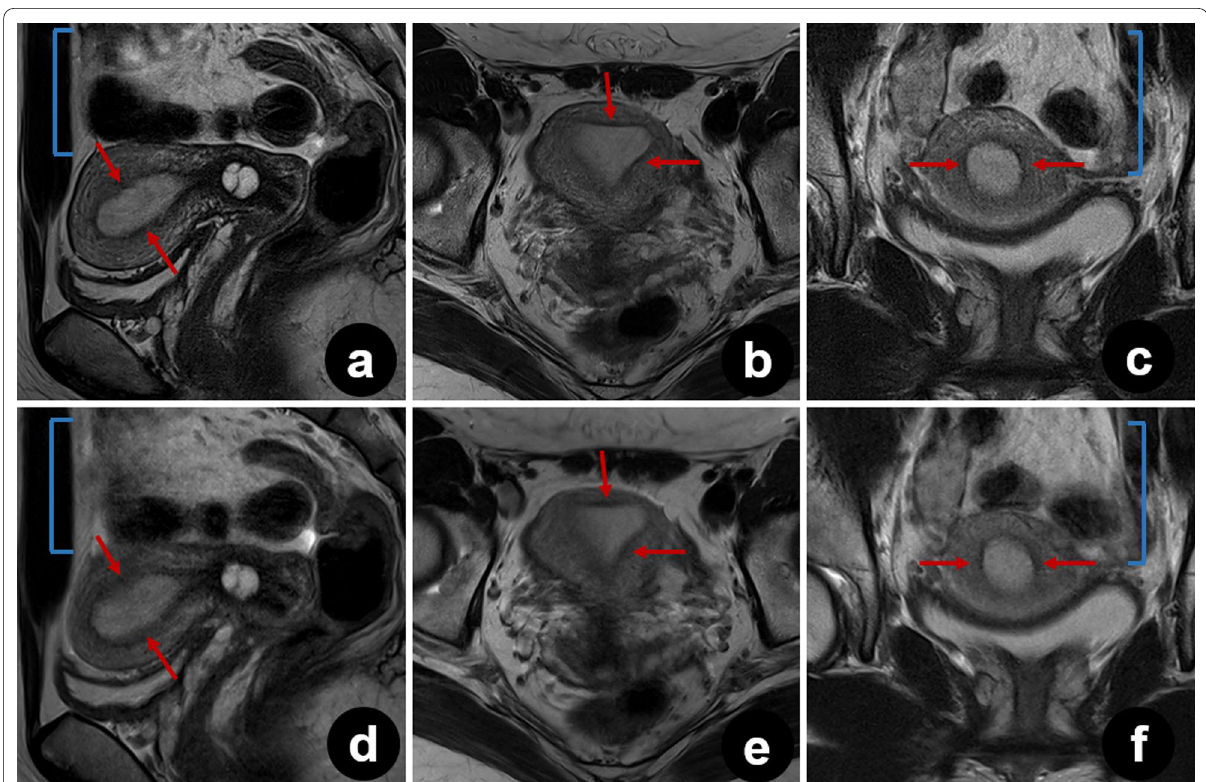
Fig. 4 Pelvic T2 DL and T2 S images of a 25‑year‑old healthy female volunteer. a – f Sagittal ( a ), axial ( b ), and coronal ( c ) T2 DL images and sagittal ( d ), axial ( e ), and coronal ( f ) T2 S images. Fewer bowel peristalsis artifacts (brackets) were observed on T2 DL images, which show sharper depiction of the uterine zonal layers (arrows). Due to severe motion artifacts (brackets), three uterine zonal layers were not clearly depicted on T2 S images (arrows). T2 DL , deep learning - accelerated T2‑weighted turbo spin echo sequence; T2 S , standard T2‑weighted turbo spin echo